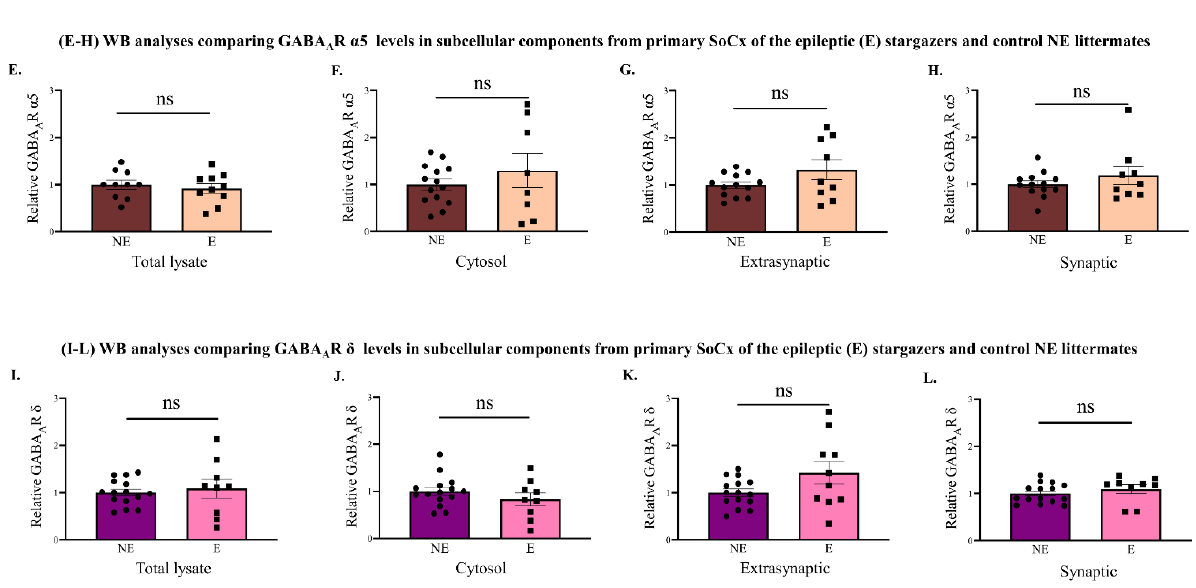
Figure 8. WB analyses of biochemically isolated fractions from primary SoCx for GABA A R α4, α5 , and δ subunits. Subcellular fractions were isolated from the control (NE) littermates and epileptic (E) stargazers. ( A − D ) Biochemical fractionation analysis revealed no significant change in GABA A R α4 in all subcellular components from th e primary SoCx of stargazers compared to their NE littermates: total lysate (NE: 1.000 ± 0.063 [ n = 9], E: 1.353 ± 0.227 [ n = 9]; p = 0.257), cytosol (NE: 1.000 ± 0.088 [ n = 14], E: 1.308 ± 0.223 [ n = 10]; p = 0.172), extra-synaptic (NE: 1.000 ± 0.051 [ n = 14], E: 0.789 ± 0.183 [ n = 9]; p = 0.516), and synaptic (NE: 1.000 ± 0.047 [ n = 14], E: 0.955 ± 0.122 [ n = 9]; p = 0.369). ( E − H ) GABA A R α5 analysis revealed no significant change in all subcellular components from the primary SoCx of stargazers compared to their control littermates: total lysate (NE: 1.000 ± 0.094 [ n = 10], E: 0.919 ± 0.102 [ n = 10]; p = 0.566), cytosol (NE: 1.000 ± 0.113 [ n = 14], E: 1.295 ± 0.362 [ n = 8]; p = 0.920), extra-synaptic (NE: 1.000 ± 0.068 [ n = 13], E: 1.324 ± 0.214 [ n = 9]; p = 0.431) and, synaptic (NE: 1.000 ± 0.075 [ n = 13], E: 1.190 ± 0.195 [ n = 9]; p = 0.744). ( I – L ) No statistically significant change was also seen for GABA A R δ subunit in all subcellular compo- nents from the primary SoCx of stargazers compared to their control littermates: total lysate (NE:1.000 ± 0.071 [ n = 15], E: 1.088 ± 0.201 [ n = 9]; p = 0.815), cytosol (NE: 1.000 ± 0.083 [ n = 15], E: 0.831 ± 0.138 [ n = 9]; p = 0.379), extra-synaptic (NE: 1.000 ± 0.078 [ n = 15], E: 1.419 ± 0.241 [ n = 10]; threshold was set at 0.05. ‘ns’ indicates no significant change found from